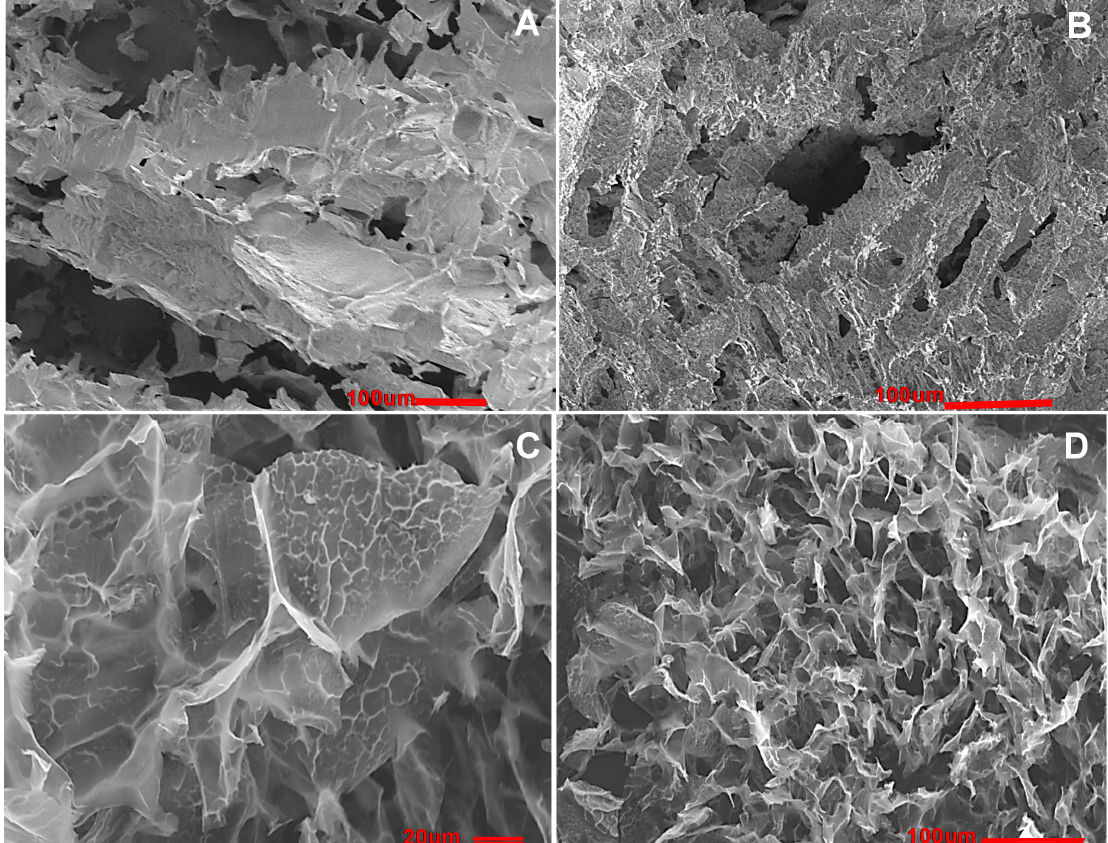
Figure 3. SEM microphotographs of composite cryogels: ( A , B ) composites PVA-CHI-hydroxyapatite-heparin-GA; scale bar 100; ( C ) polyelectrolyte complex PVA-CHI-heparin-GA scale bar 20 [35] and ( D ) CHI-GA; scale bar 100 [44].